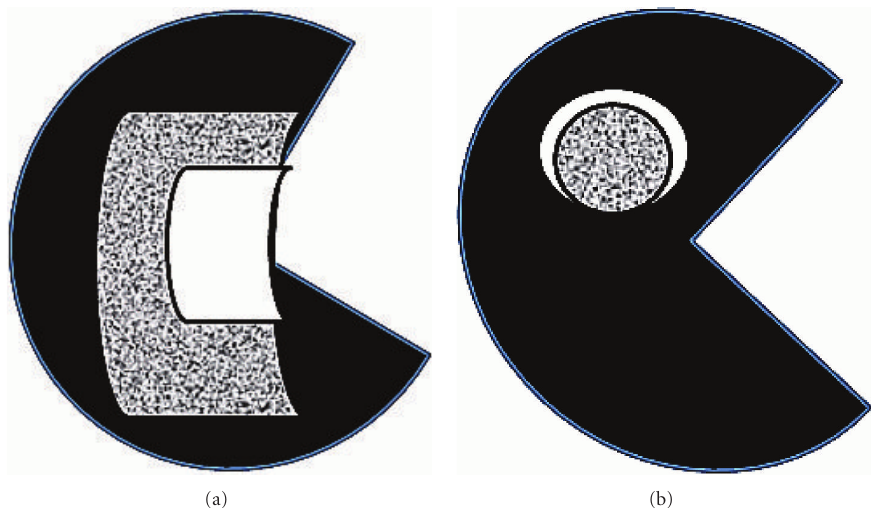
Figure 8: Comparison between myocardial edema (white) and scarring (dotted) in the myocardium. (a) At the acute stage of ischemic or inflammatory cardiomyopathy, myocardial edema is associated with smaller myocardial scarring or its absence. (b) In some types of nonischemic cardiomyopathy, myocardial edema is smaller than the scarring, indicating relapsed ischemia.